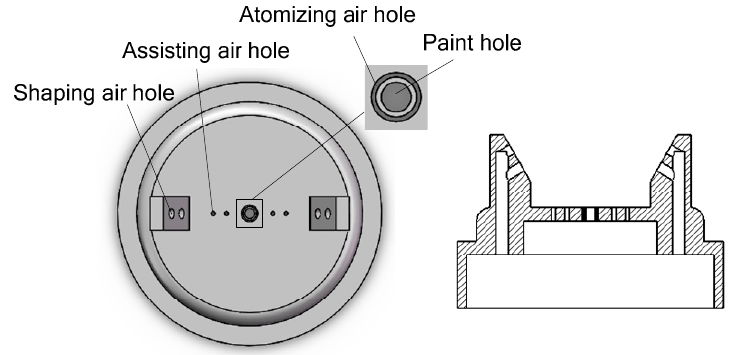
Figure 2. Geometry of the air cap.